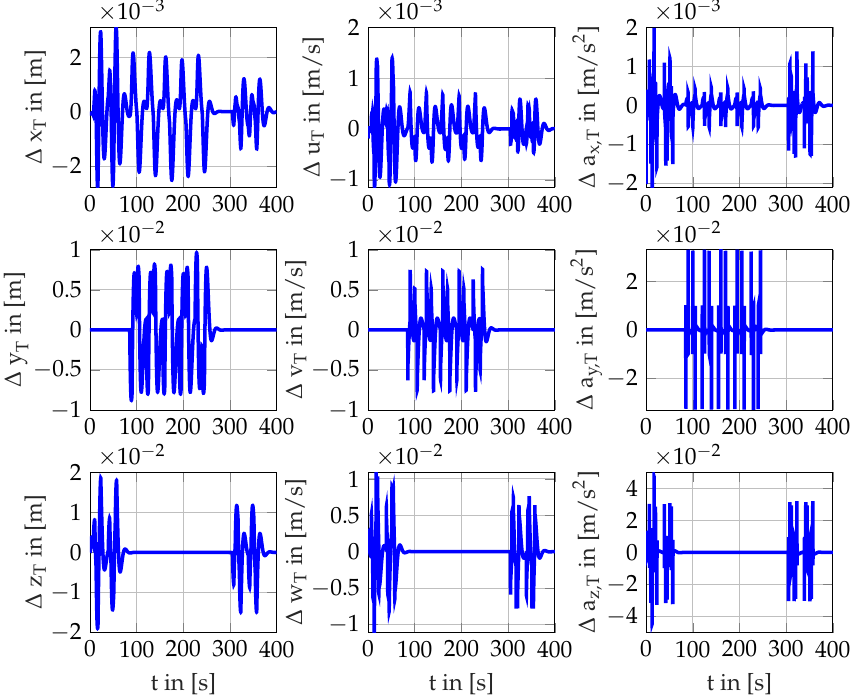
Figure 5. Trajectory position, velocity, and acceleration deviations in all three axes along the